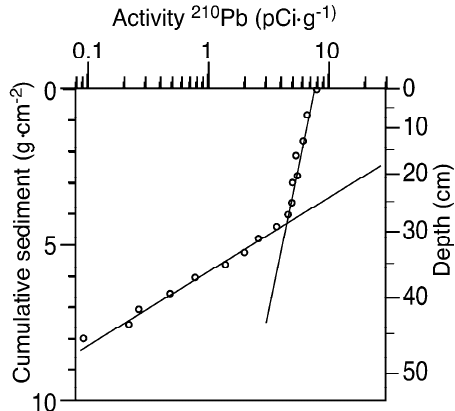
Figure 2. Semi-logarithmic plot of the unsupported 210 Pb activity (1 pCi = 0.037 Bq) versus cumulative sediment mass for Lake West Okoboji with least square fitted lines for the upper 8 and bottom 9 points. The intersection of the lines defines the depth of the mixed zone. Data points from Heathcote et al. [9].